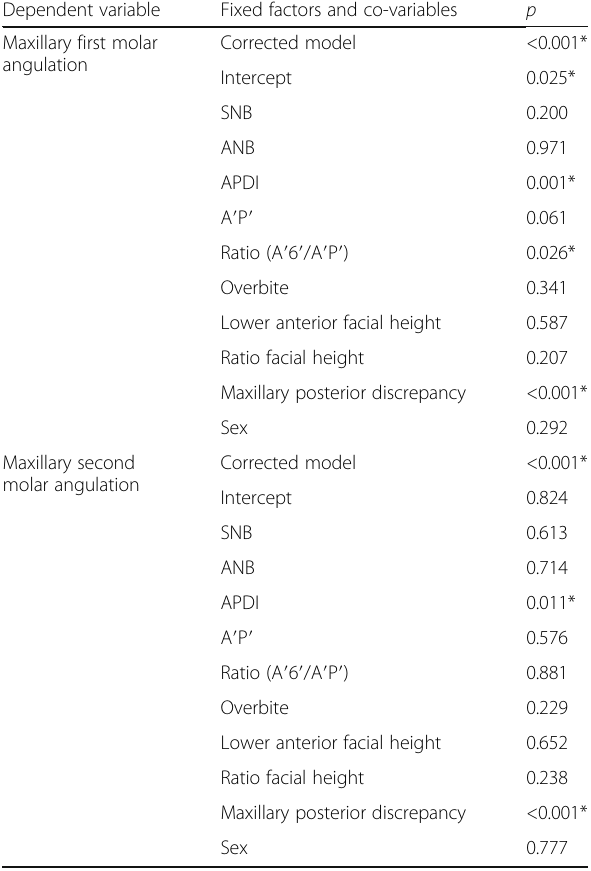
Table 7 MANCOVA assessing maxillary first and second molar angulations based in fixed factors and co-variables